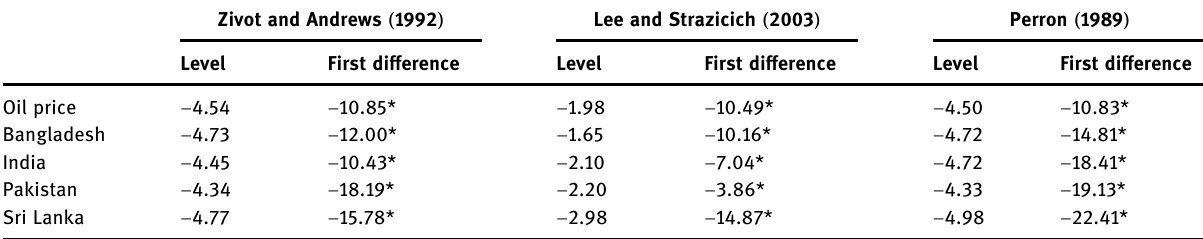
Table 3: Stationarity